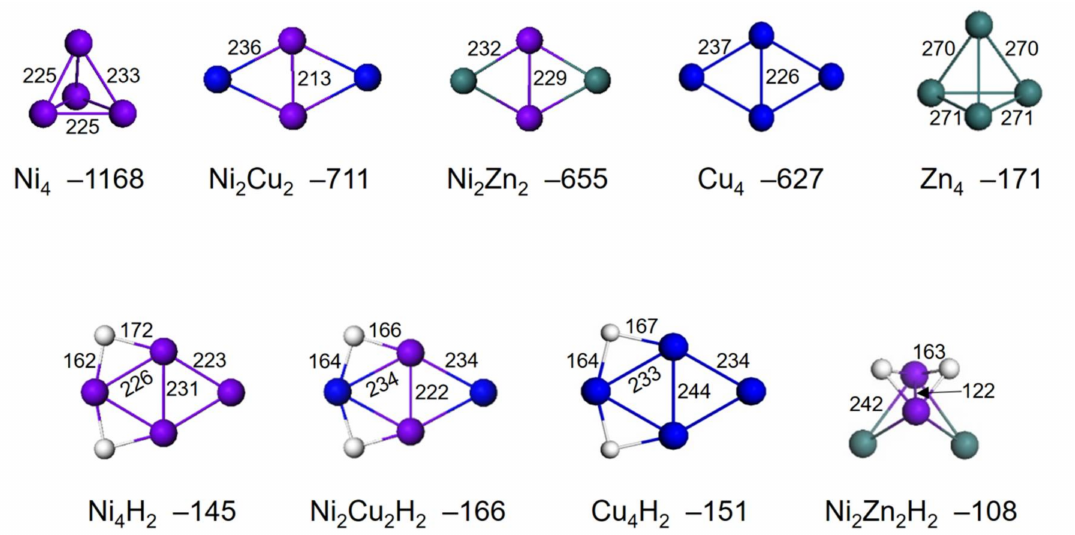
Figure 8. The structures, bond distances (pm), binding energies (kJ / mol), and adsorption energies (kJ / mol) for H 2 on metal clusters. H, Ni, Cu, and Zn atoms are shown in white, violet, blue, and olive green,